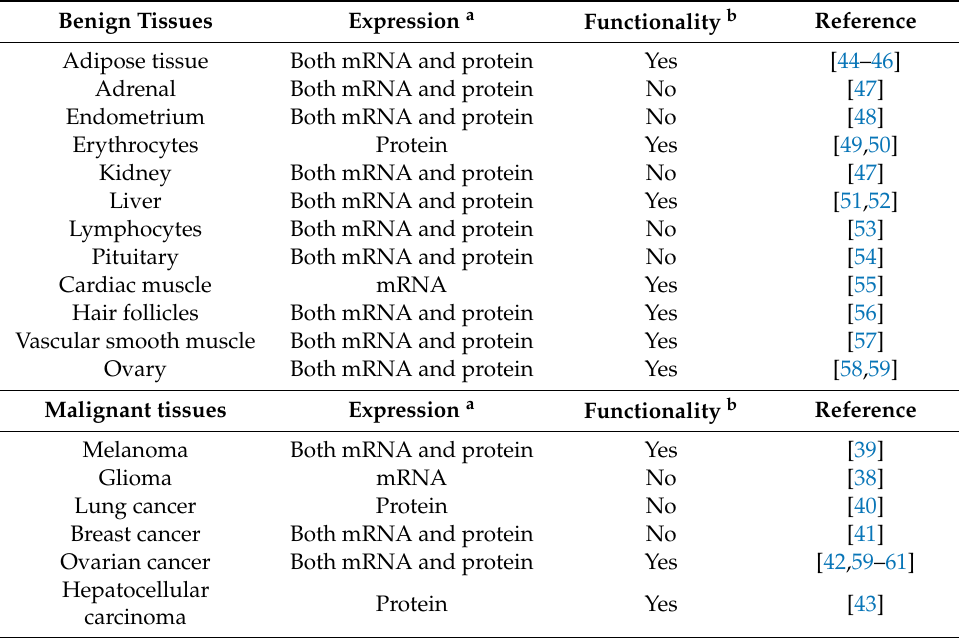
Table 1. Summary of evidences of TSHR expression in human extra-thyroid tissues or